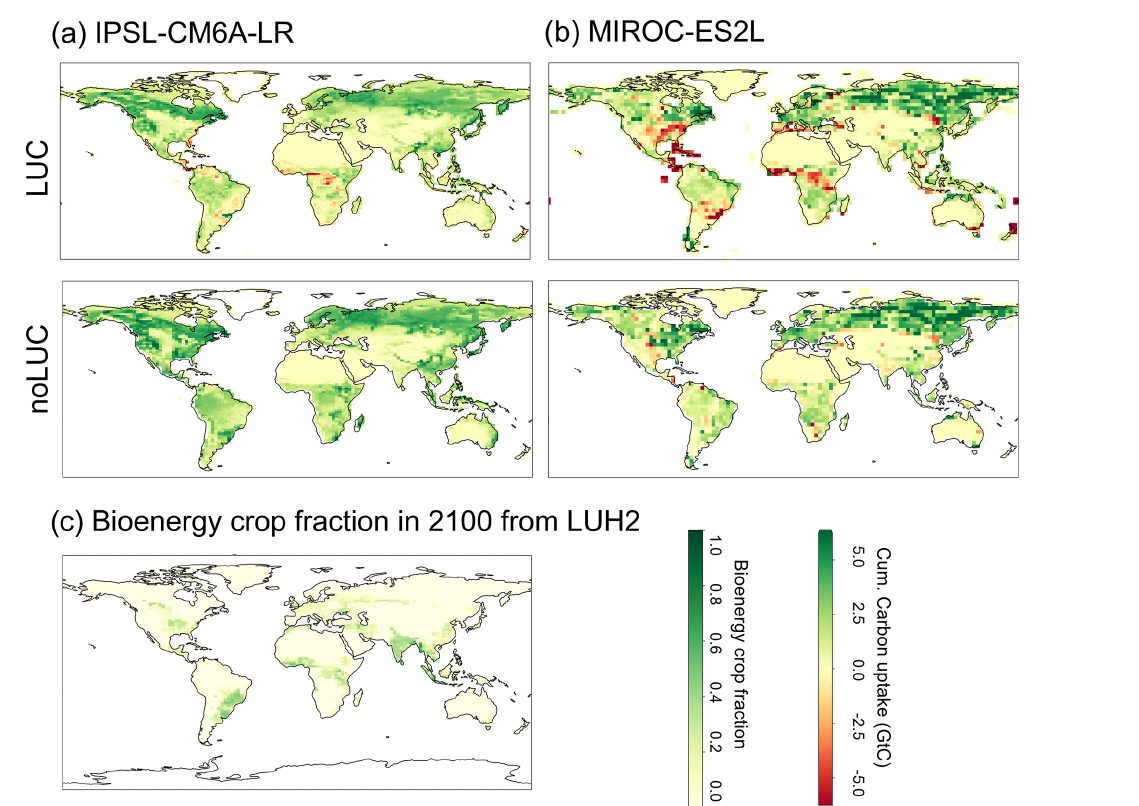
Figure 5. Spatial variations of the cumulative over 2040–2100 period carbon uptake by (a) IPSL-CM6A-LR and (b) MIROC-ES2L given for the fully coupled simulations with and without LUC. The negative values indicate less sink/larger source from land to atmosphere. (c) The bioenergy crop area in 2100 from